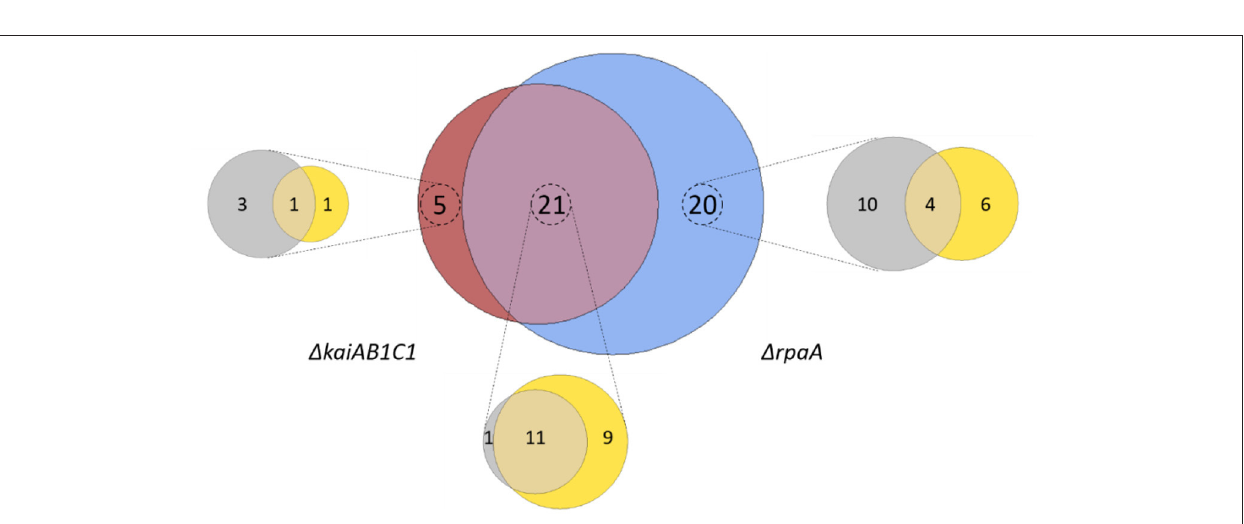
FIGURE 6 | Summary of the metabolic changes in the mutants of Synechocystis . Venn diagram analysis of all significant (Tukey test, P < 0.05) metabolic changes among the set of identified and yet unidentified metabolites. Intersections show significant changes in the metabolite pools shared between the 1 kaiAB1C1 (brown) and 1 rpaA (blue) mutants. Zoom-ins show the contribution of the two diurnal phases to the respective sets, D phase (gray) and L phase (yellow). Note the large overlap between the mutants and the more frequent specific responses of the 1 rpaA